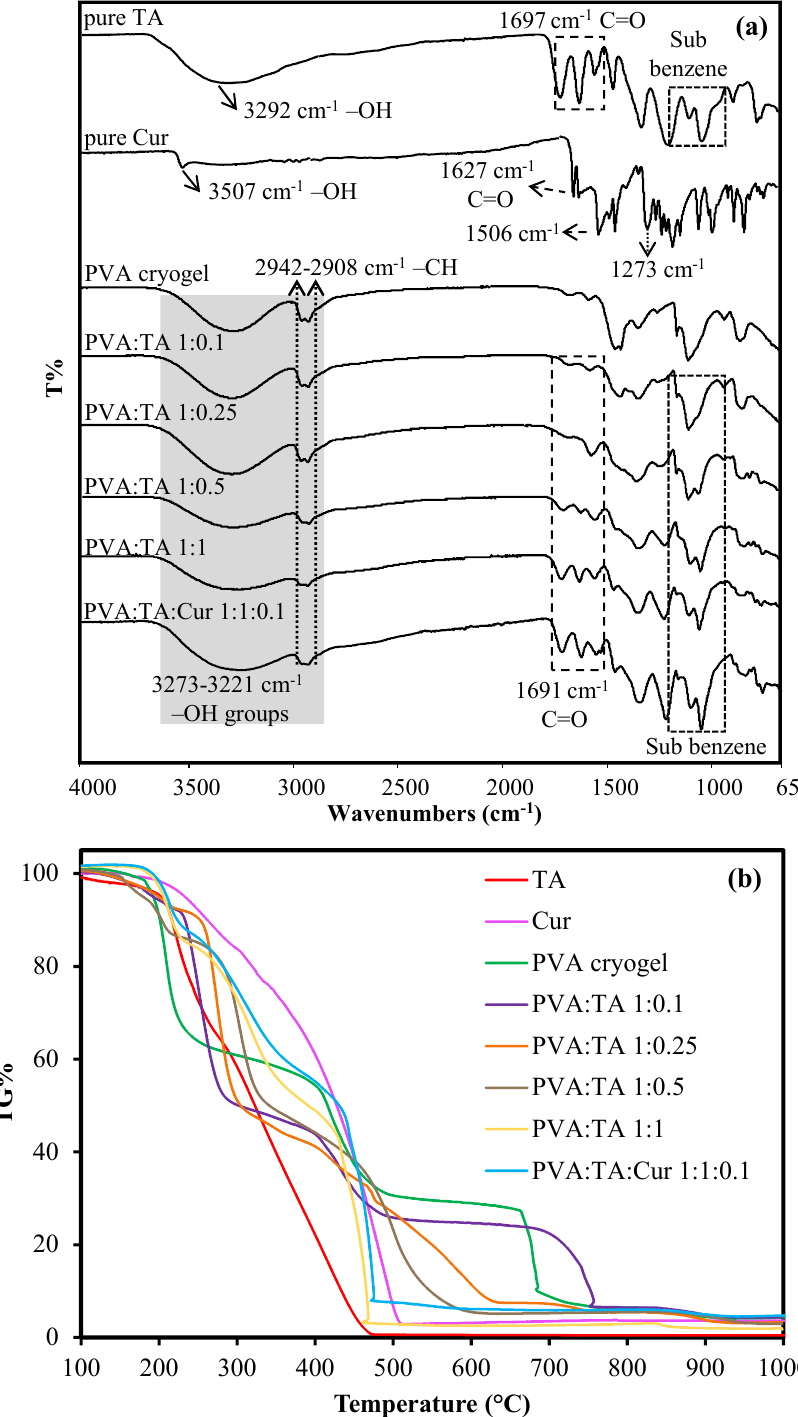
Figure 2. ( a ) FTIR spectra and ( b ) TG thermograms of pure TA, pure Cur, PVA cryogel, PVA:TA, and Figure 2. (a) FTIR spectra and (b) TG thermograms of pure TA, pure Cur, PVA cryogel, PVA:TA, PVA:TA:Cur cryogel and PVA:TA:Cur cryogel composites.